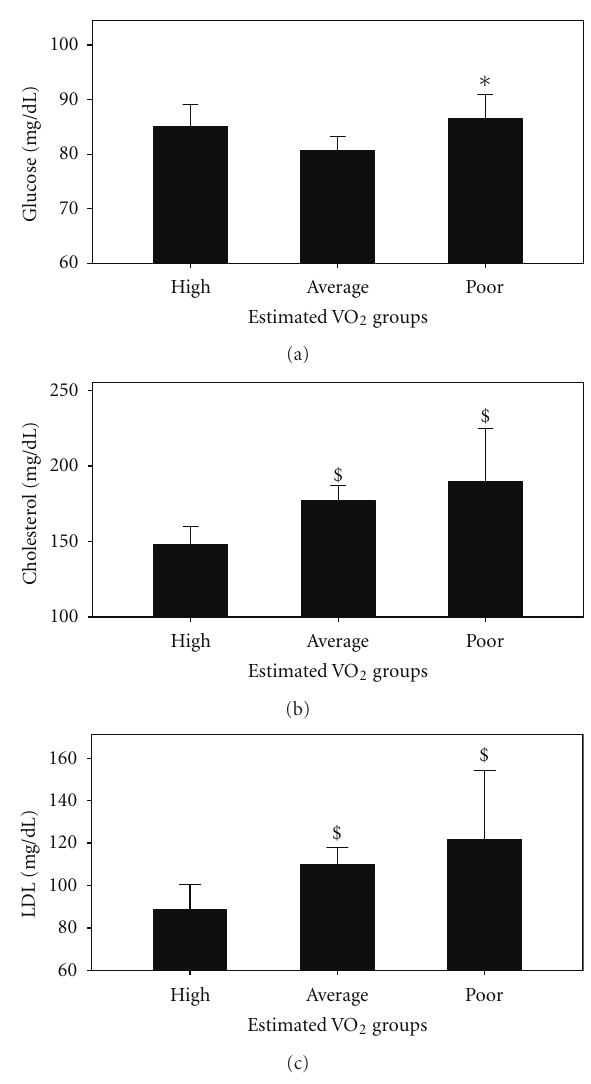
Figure 7: Blood glucose (a), cholesterol (b), and LDL-C (c) in the poor, average, and high estimated VO 2 max groups. ∗ = P < 0 . 05 versus average group; $ = P < 0 . 05 versus high